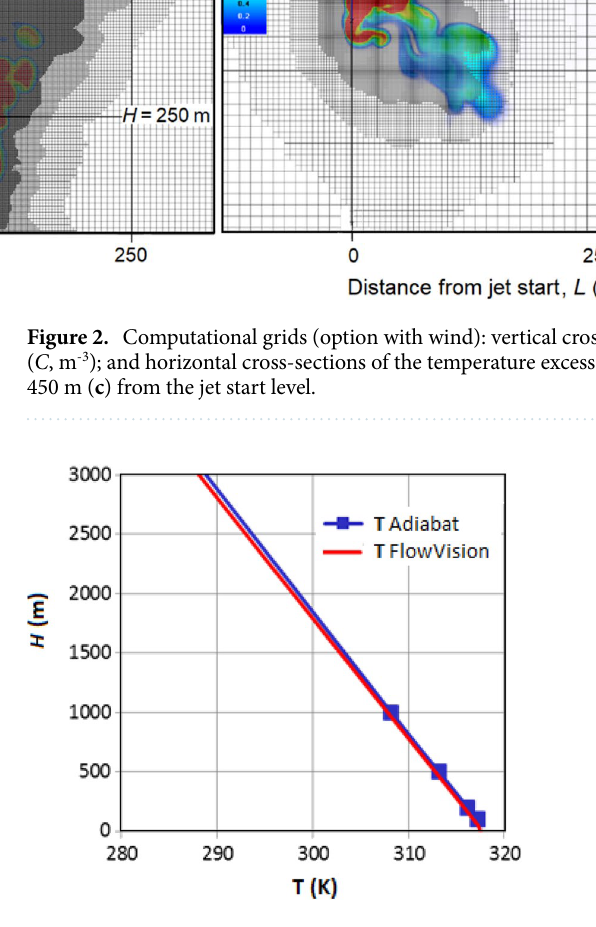
Figure 3. Comparison of temperature graphs for adiabatic rise and in